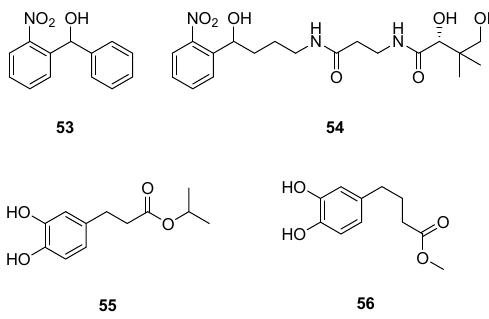
Table 7. Anti-QS and anti-virulence properties of PqsD inhibitors. Anti-QS Properties QSIs